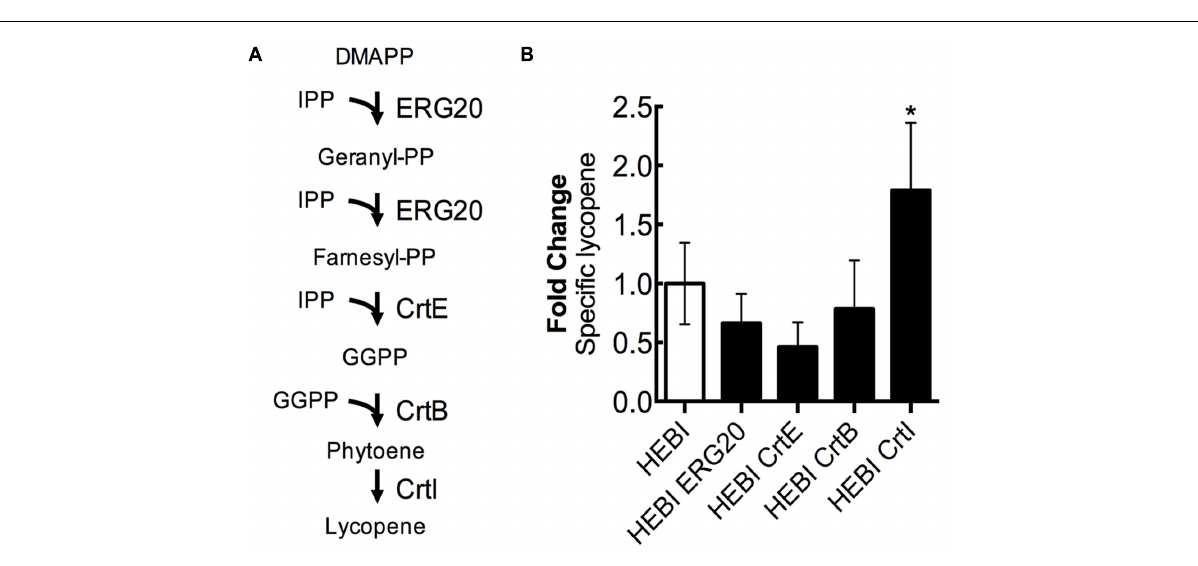
catalyzed by lycopene synthase (CrtI, from P. ananatis ) to yield